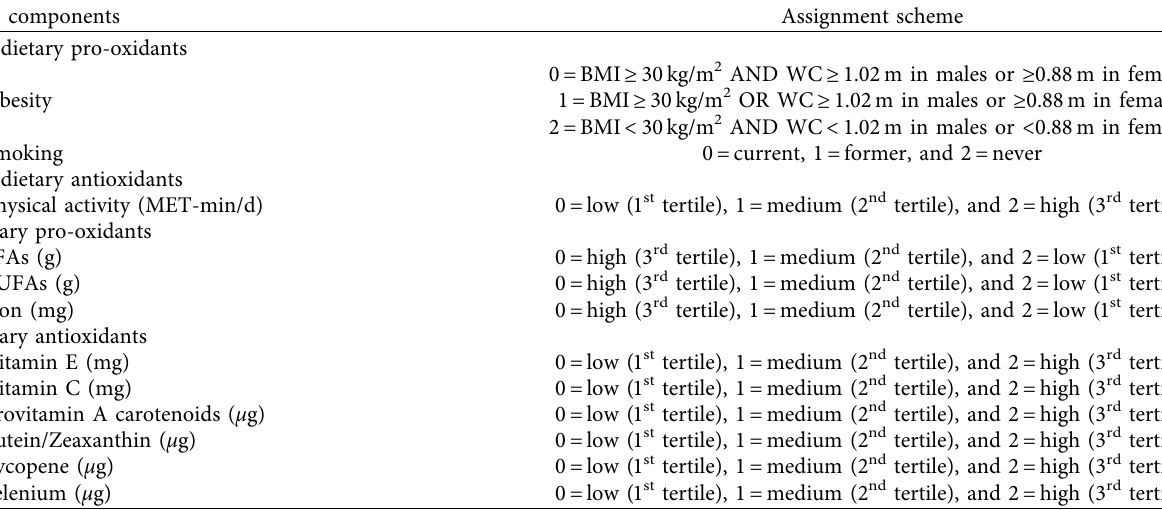
Table 1: Oxidative balance score components.